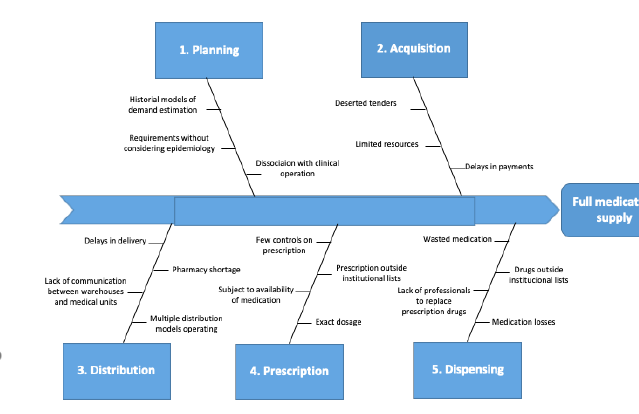
Figure 3. Out-of-pocket expenditure on household health in Mexico, 20016-2018.